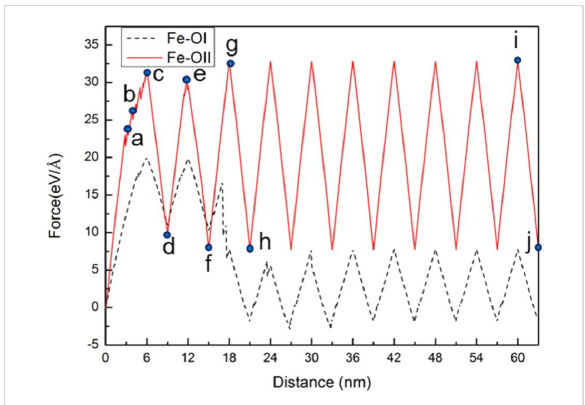
Figure 19: Force–distance curves of Fe along the orientation I (black dashed line) and orientation II (red line) under ten times of cyclic loading, where the first shear distance of the sample was 6 nm, and the reverse shear and shear distance were 3nm. The letters a–j repre- sent the observation positions in Figure